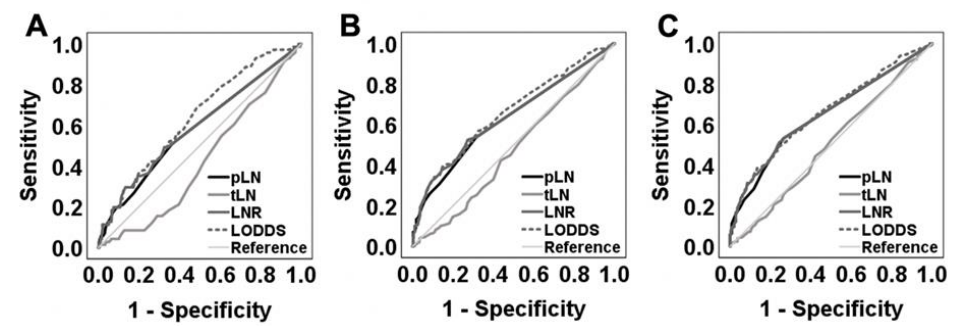
Figure 1. ROC analysis of various LN classification systems. ROC curves were generated for LNR, LODDS, pLN (positive lymph nodes), tLN (total lymph nodes) as categorical variables to predict ( A ) 1-year OS, ( B ) 3-year OS and ( C ) 5-year OS.